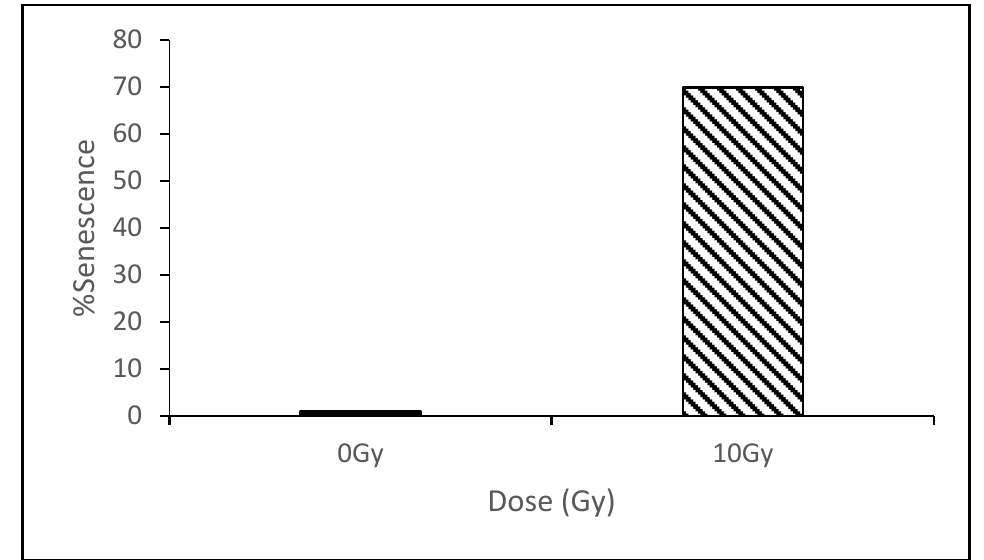
Figure 1. Following exposure to 10 Gy irradiation, 70.9% of cells showed a senescence phenotype compared to < 1% for sham exposed cells.